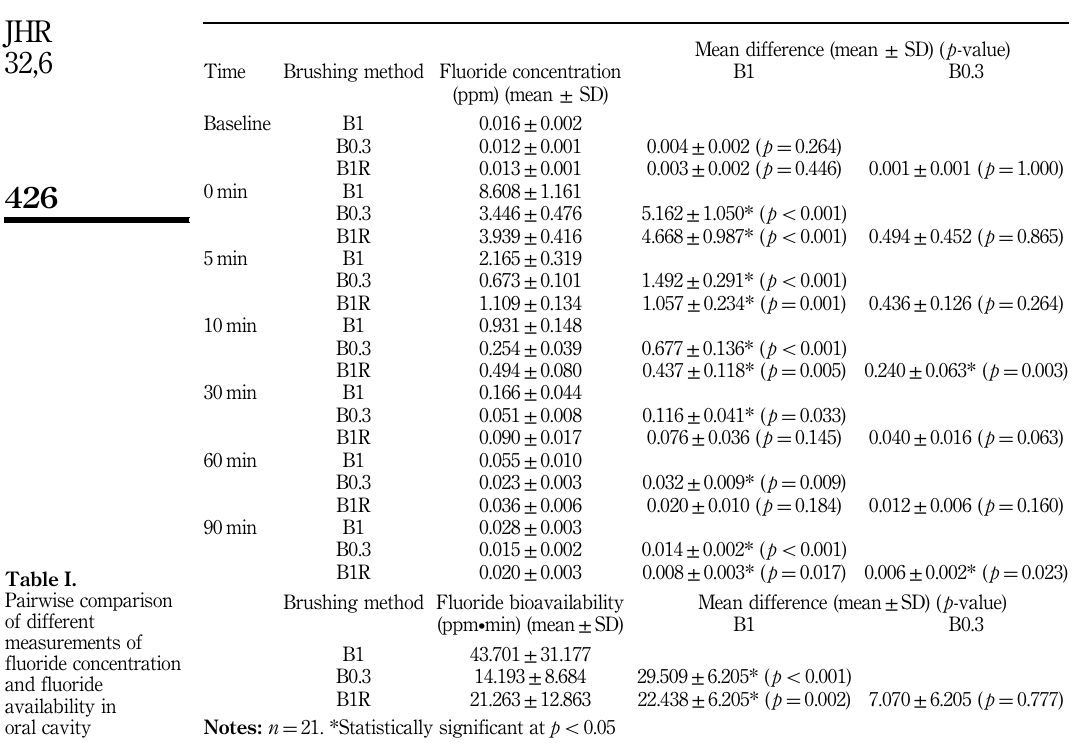
Half-life of fluoride in the oral cavity The t of F concentration occurred into two phases: the initial phase during which F 1/2 rapidly decreased from 0 to 10 min and the late phase during which F slowly decreased at of B1 and B1R groups were significantly longer compared with 30 – 90 min. The initial t 1/2 the B0.3 group ( p ¼ 0.042 and p ¼ 0.001, respectively), but there was no significant difference between the B1 and B1R groups ( p ¼ 0.691) (Table II). The late t group was significantly longer compared with the B1 group ( p ¼ 0.015) while that of the B1R group was not different from those of the B1 and B0.3 groups ( p ¼ 0.724 and p ¼ 0.268, respectively) (Table II).